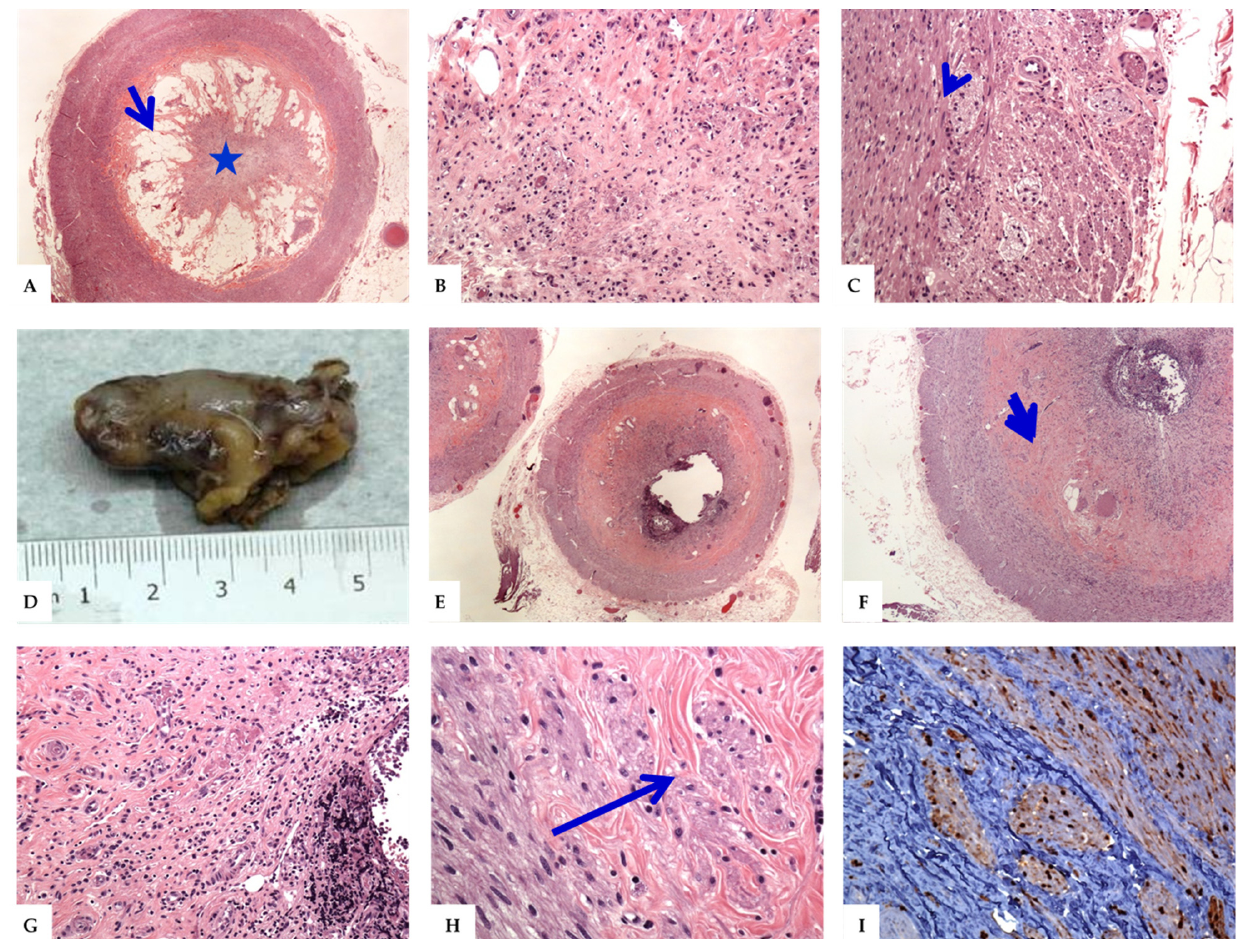
Figure 3. The histological features of the central and submucosal variants of neurogenic appendicitis. ( A – C ): Sections from the appendix showing the formation of a small central neuroma (a central variant of neurogenic appendicitis). The histological features include obliteration of the lumen by the admixture of fibrous and neural elements ( A : star) with extensive submucosal aggregates of mature adipose tissue ( B ) and hypertrophied nerve bundles ( C : arrowhead). ( D ) : Grossly, the appendix measures 3.5 cm in length × 1.0 cm in circumference with attached mesoappendix (2 × 0.5 × 0.5 cm). The serosal surface is smooth and glistening. There are no perforations of the appendiceal wall or purulent materials. The mesoappendix has a yellow appearance, without areas of hemorrhage or necrosis. ( E – H ) On microscopy, sections reveal features of the submucosal variant of neurogenic appendicitis including extensive loss of the mucosal glands, crypts, and lymphoid follicles, associated with the expansion of the submucosa by the admixture of fibrous and neural tissues (blue short arrow) with hypertrophied nerve bundles (neurogenous hyperplasia, long blue arrow) that are reactive for S100 immunostain ( I ). The presence of lymphomononuclear cells is indicative of repeated attacks of minimal subclinical mucosal inflammation (Original magnifications, A : ×20, B : ×200, C : ×200, E : ×20, F : ×40, G : ×200, H : ×400, and I : ×200).